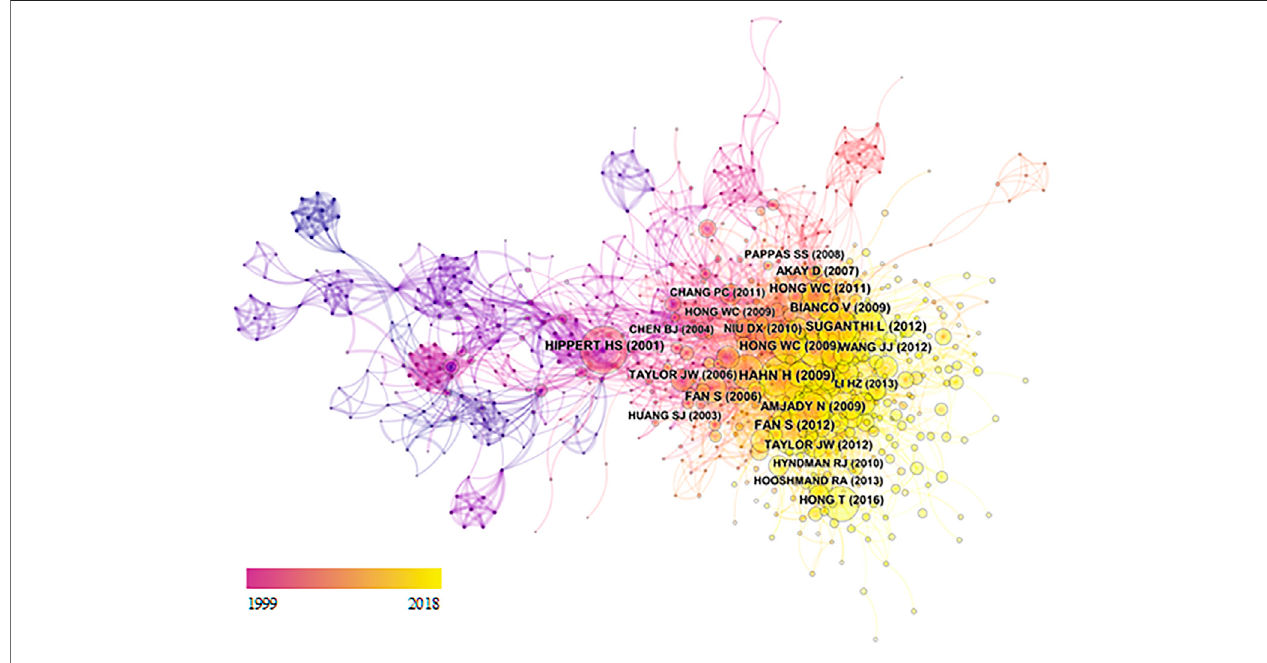
FIGURE 10 | Reference co-citation network in electricity demand forecasting.